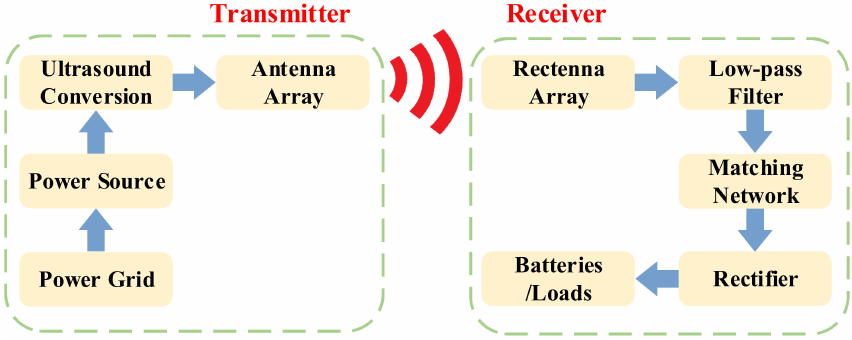
Figure 3. Components and fundamentals of the US-WPT